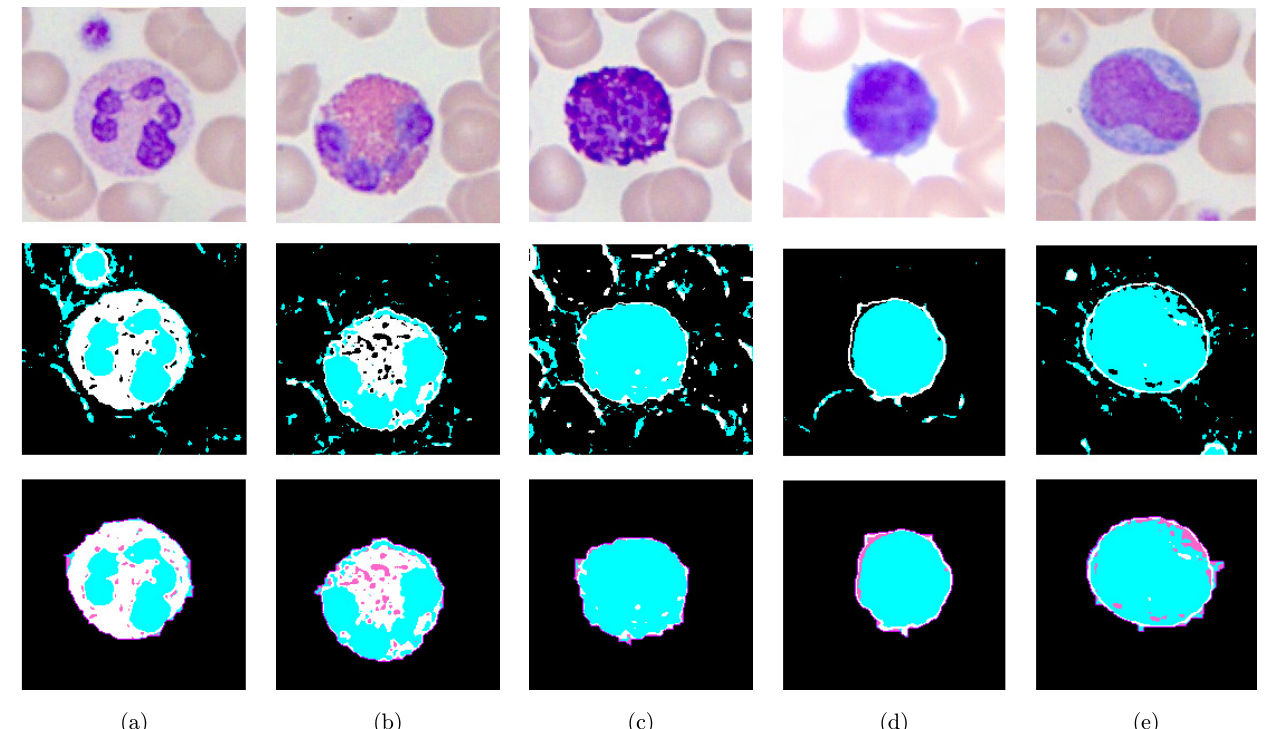
Fig. 13. Five types of leukocyte are segmented by HSI color system and shape ¯lter. (a) Neutrophil, (b) eosinophil, (c) basophil, (d) lymphocyte and (e)